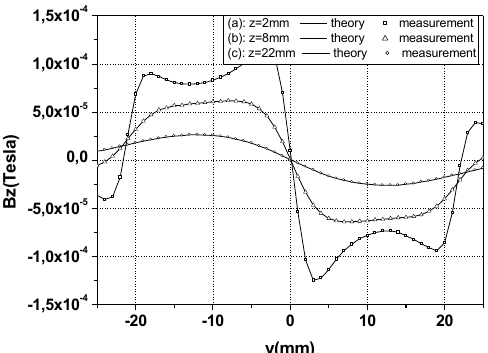
Figure 3: Magnetic field evaluation and measurement for the excitation coil in air for different values of altitude z Clearly, this means that the magnetic field of the currents induced in the plate is totally negligible in comparison to the exciting field [22 and 23]. Therefore, the plate can be viewed as shown in figure 4.